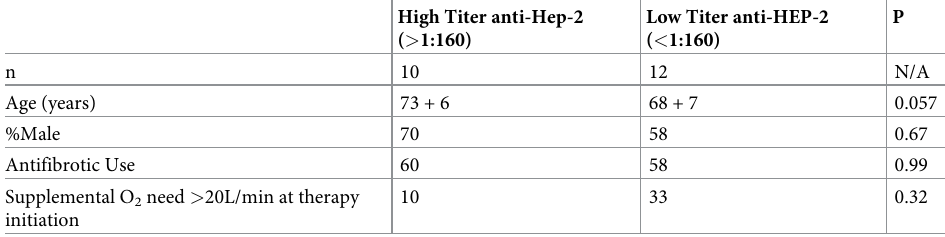
Table 3. Associations with anti-Hep-2 titers at initiation of